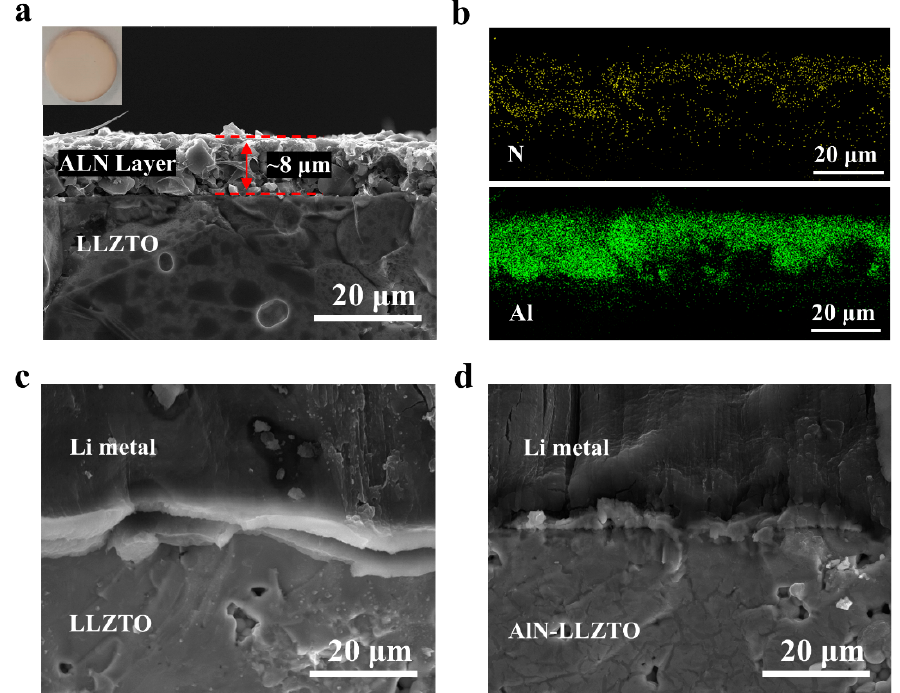
Figure 3. Cross section SEM image of the AlN-LLZTO ( a ), and the corresponding EDS mappings of N and Al ( b ). The inset is a photo of the AlN-LLZTO pellet. Cross-section SEM images of the Li/LLZTO interface ( c ) without- and ( d ) with AlN-interlayer.